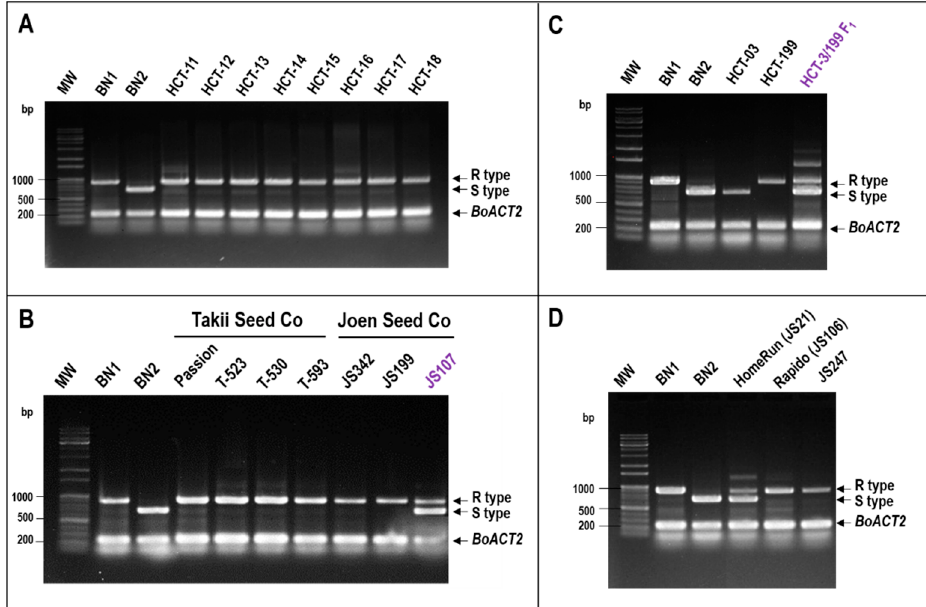
Figure 9. Validation of hot tolerance of cabbages provided by Joen Seed Co. ( A ) Inbred lines that have been used for hot / cold tolerance source. ( B ) Cabbages that have been used for heat-tolerant and flat head sources. JS107 was a heat-susceptible line used as a reference, which was hybrid of HCT-07 and HCT-08 in Figure 7B. ( C ) Breeding material for hot tolerance selection. ( D ) Three representative cultivars for selling.